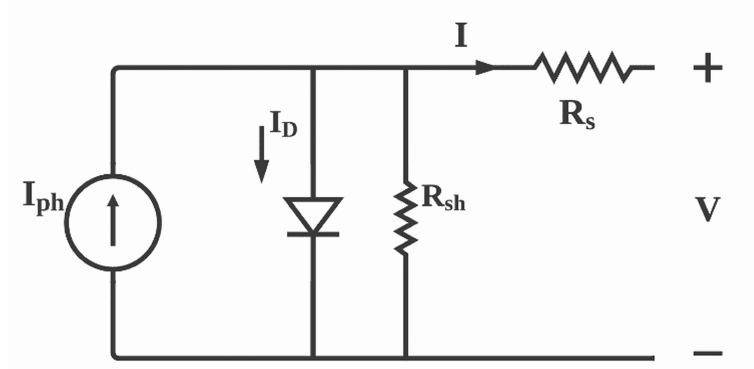
Figure 1. Single diode model of solar cell: I is the device current, V is the cell voltage, K B is the Boltzmann’s constant and T is the absolute